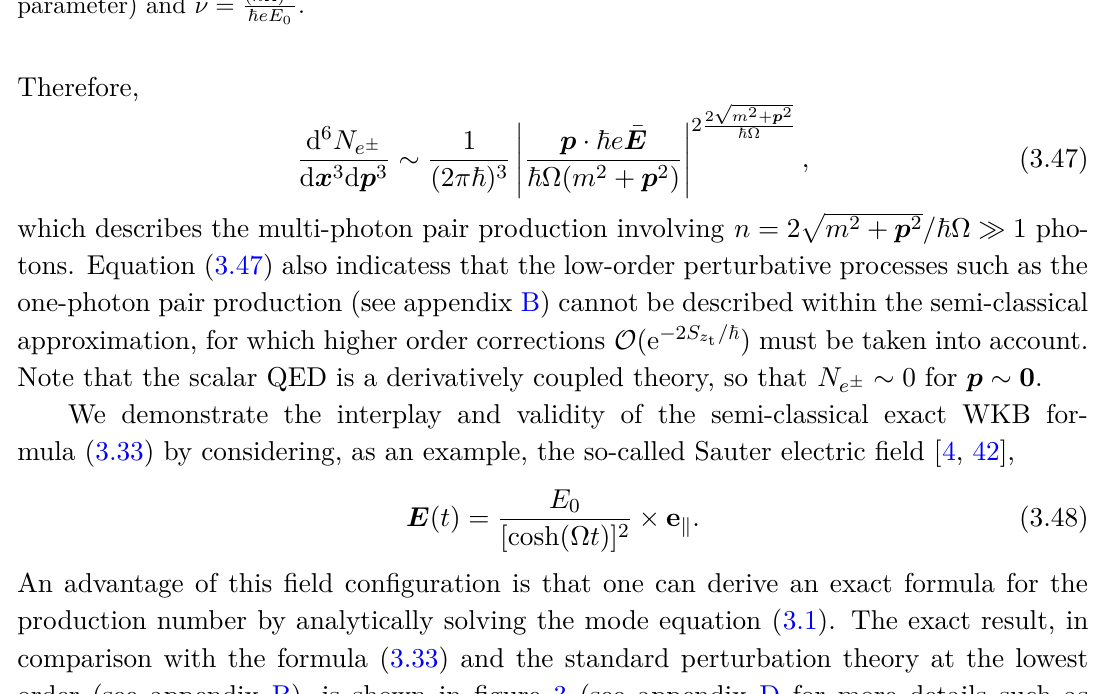
Figure 3 . (color online) The production number N for the Sauter electric field (3.48) with e − parameters | p ⊥ | /m = 0 , p /m = 0 . 20 , and ~ eE 0 /m 2 = 0 . 25 . The black line shows the exact k result (D.5), and colored lines show different theoretical predictions: the semi-classical exact WKB formula [eq. (3.33) or (D.11)] (long dashed blue line), the lowest order standard perturbation theory [eq. (B.10) or (D.14)] (short dashed red line), and the Schwinger formula for a constant electric field (3.43) (green line). The background shading distinguishes values of γ = m ~ ω (i.e., the Keldysh ~ eE 0 parameter) and ν = ( ~ Ω) 2 ~ eE 0